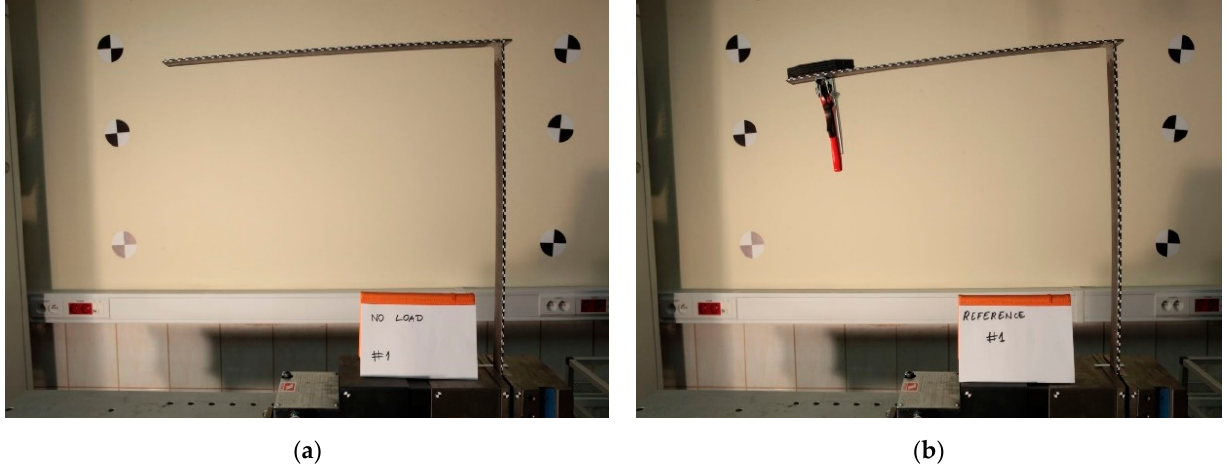
Figure 3. Images of the structure captured in the tests: unloaded state ( a ) and loaded state ( b ).